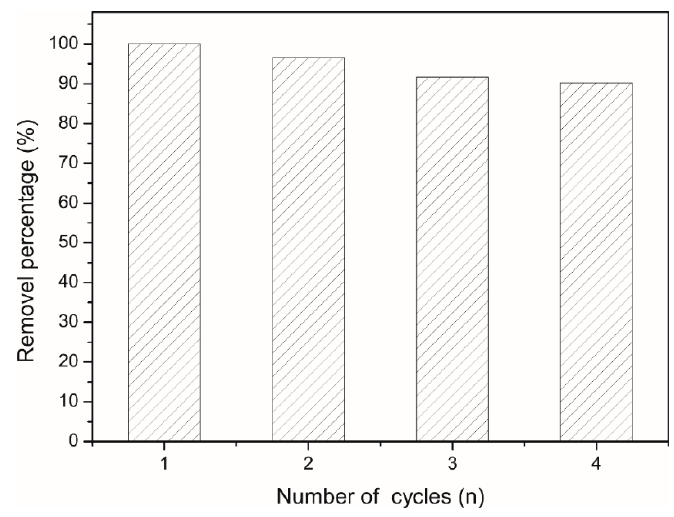
Figure 11. Number of cycles.